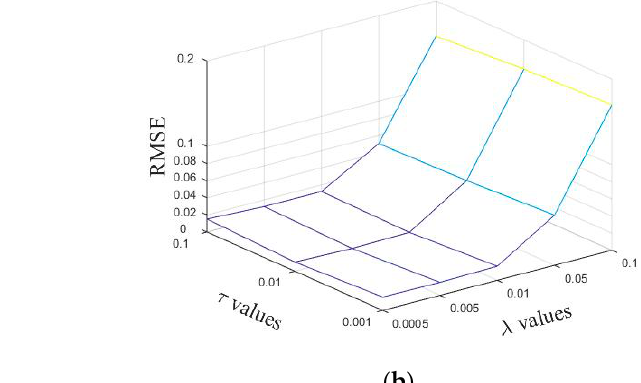
Figure 3. Performance of SSC-NMF with respect to parameters τλ , in terms of ( a ) SAD (Spectral Angle Distance) and ( b ) RMSE (Root Mean Square Error). Angle Distance) and ( b ) RMSE (Root Mean Square